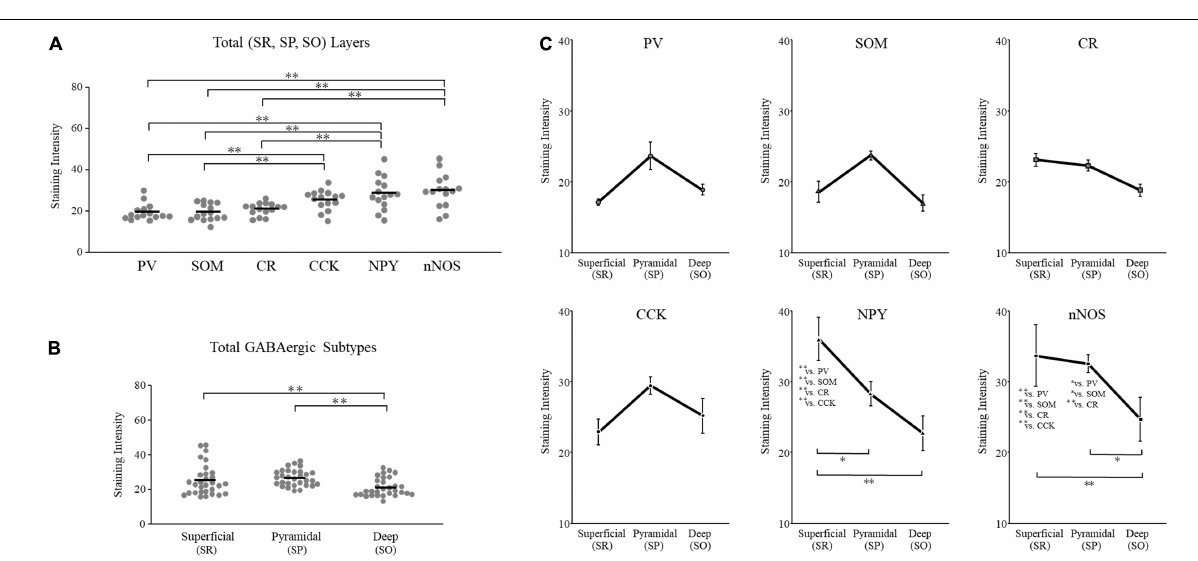
Frontiers in Behavioral Neuroscience |